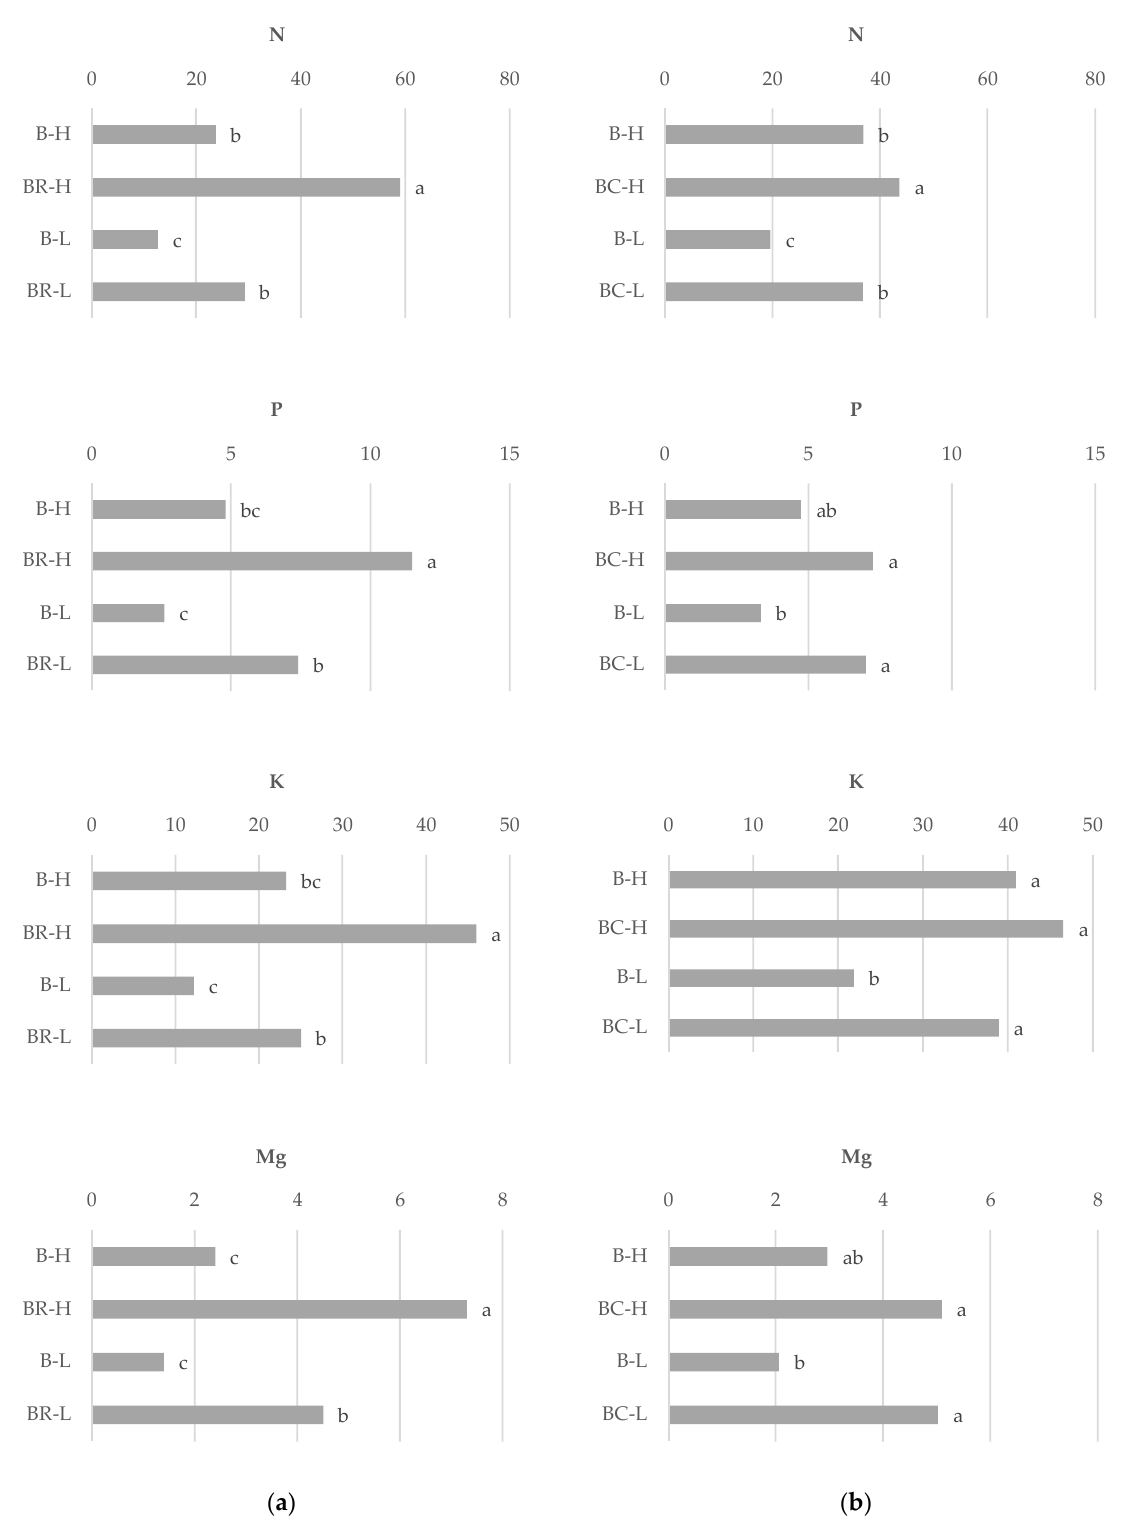
Figure 2. Nutrient accumulation in post-harvest residue biomass, mg pot –1 : ( a ) Experiment I, with Italian ryegrass as CC; ( b ) Experiment II, with red clover as CC. Different letters next to the bars indicate significant differences at p < 0.05. In Experiment II, more N was accumulated in BC-H plant residues than in B-H plant residues, while the amounts of P, K, and Mg in BC-H and B-H residues were the same. Water deficit was the cause of reduced N and K accumulation in the residue of B-L plants